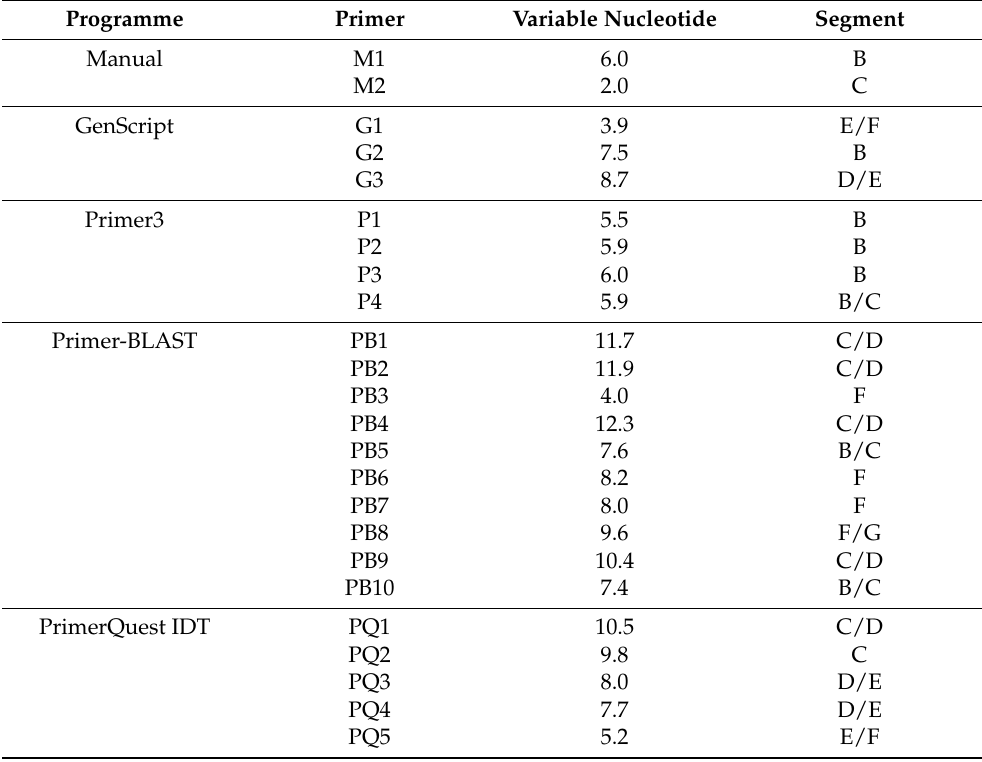
Table 3. Details of primer pairs generated by manual and programs.